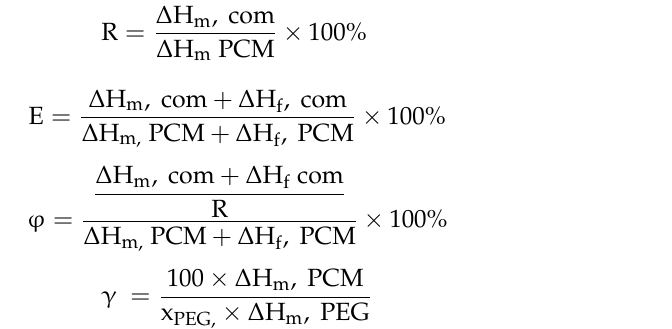
In Equations (1)–(4), com = 5-MCC, 10-MCC or 15-MCC support and PCM = support + PEG, where T m = melting temperature, ∆ H m = the latent heat in the heating process, T f = freezing temperature, ∆ H f = the latent heat in the cooling process, ∆ T s , = supercooling, X PEG = PEG weight fraction in PCM, R% = impregnation ratio, E(%) = impregnation efficiency, ϕ % = Energy storage ability (capability), and γ % = heat storage efficiency. The experimental thermal storage efficiency was also calculated using Equation (4)